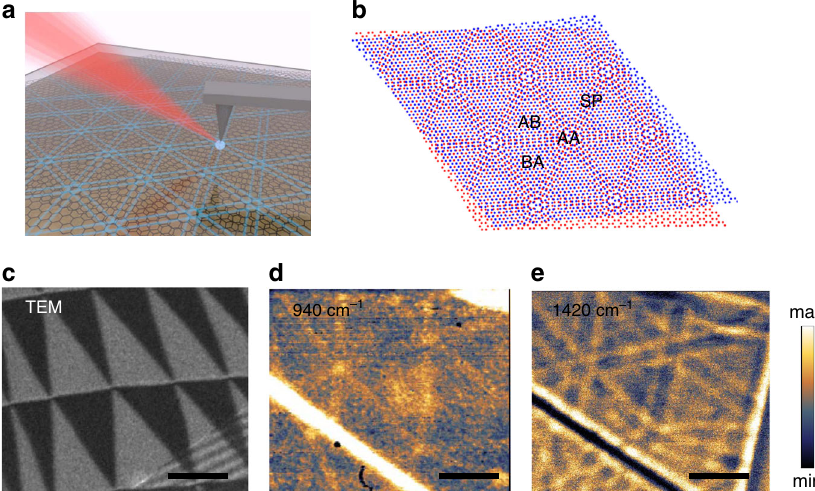
Fig. 1 Overview of near- fi eld nano-imaging of the hybridized response in twisted bilayer graphene heterostructure. a Experimental schematic showing infrared light beams incident and scattered by an atomic force microscope tip. The near- fi eld response is detected through the scattered light in the far- fi eld. b Schematic diagram of twisted bilayer graphene showing different stacking con fi gurations. c Transmission electron microscopy (TEM) dark- fi eld image obtained by selecting the graphene diffraction peak in a TBG. The contrast of AB/BA domains is associated with the antisymmetric shift of lattice period in AB and BA domains. d and e Near- fi eld images of the normalized near- fi eld scattering amplitude s ( ω ) in false color maps revealing the domain walls in TBG without bottom h-BN taken at 940 cm − 1 ( d the plasmon polariton resonant wavelength) and 1420cm − 1 ( e the phonon polariton resonant wavelength). The twisted angle is about 0.02°. The contrast seen of the domain walls is associated with the re fl ectivity of the plasmon polariton in graphene and phonon polariton in h-BN, respectively. Scale bar: 500 nm. Note: this sample was purposely doped to increase the plasmonic